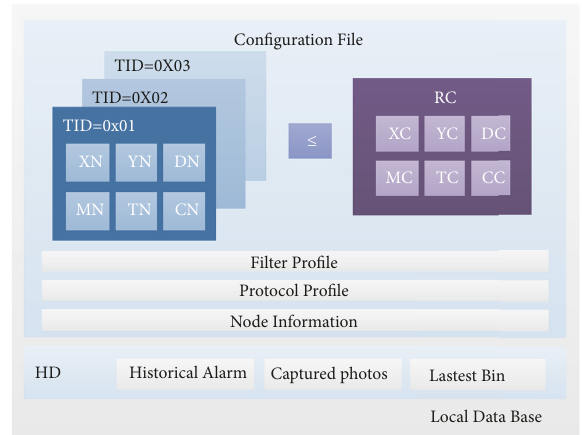
Figure 3: Contents of the configuration file in the local